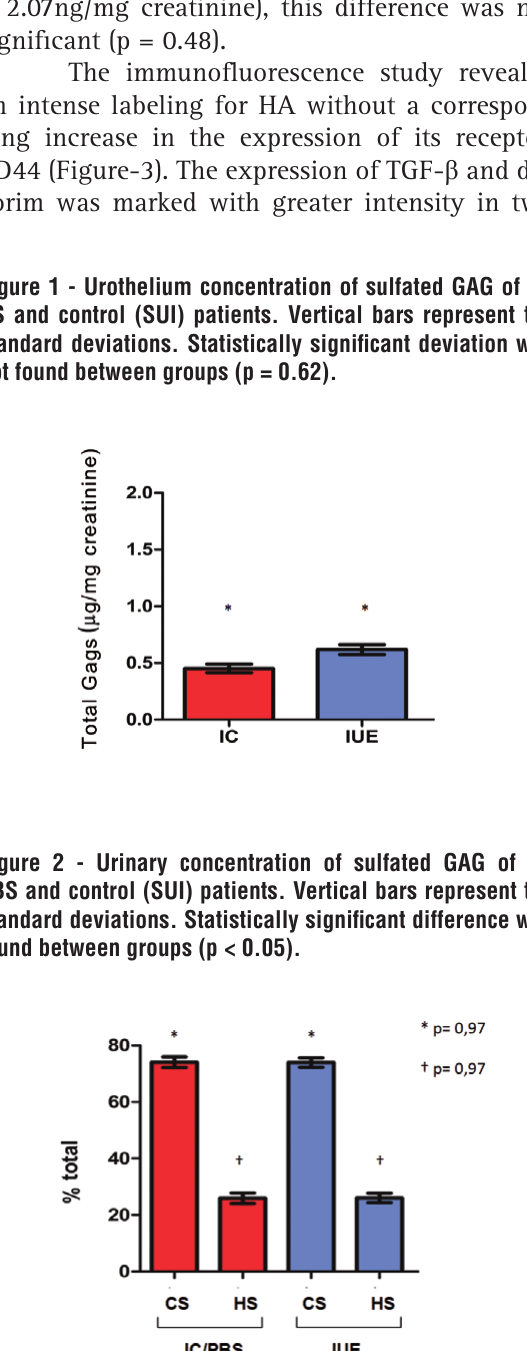
Figure 3 - Immunoflurorescence of hyaluronic acid (HA) and its receptor (CD44) in the bladder urothelium. The tissue of SIU patients (CTR) and IC/PBS patients (PAT) were labeled with anti-HA receptor (green) and a protein biotinylated HA binding (red). The nuclei were stained with DAPI (blue). The overlap of the markings appears in the right pane (merged). Scale bar: